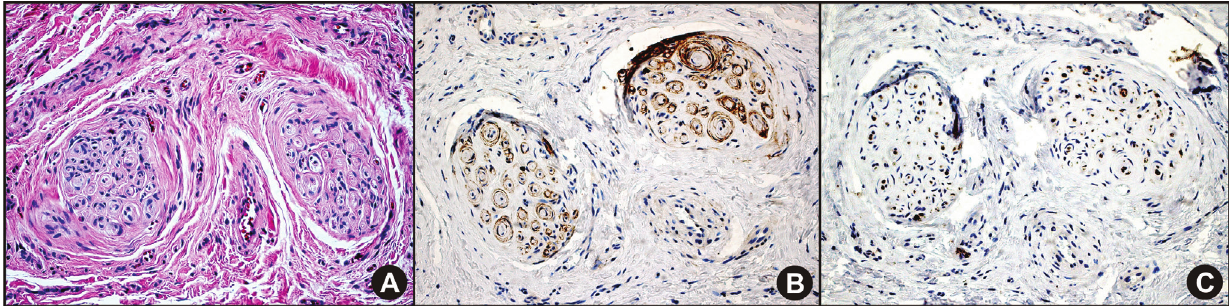
encircle negative Schwann cells and axons (original magnification x200). C - Immunoexpression of S-100 protein in the myelin sheath and Schwann cells, surrounded by perineurial cells that were negative for S-100 protein(original magnification x200)